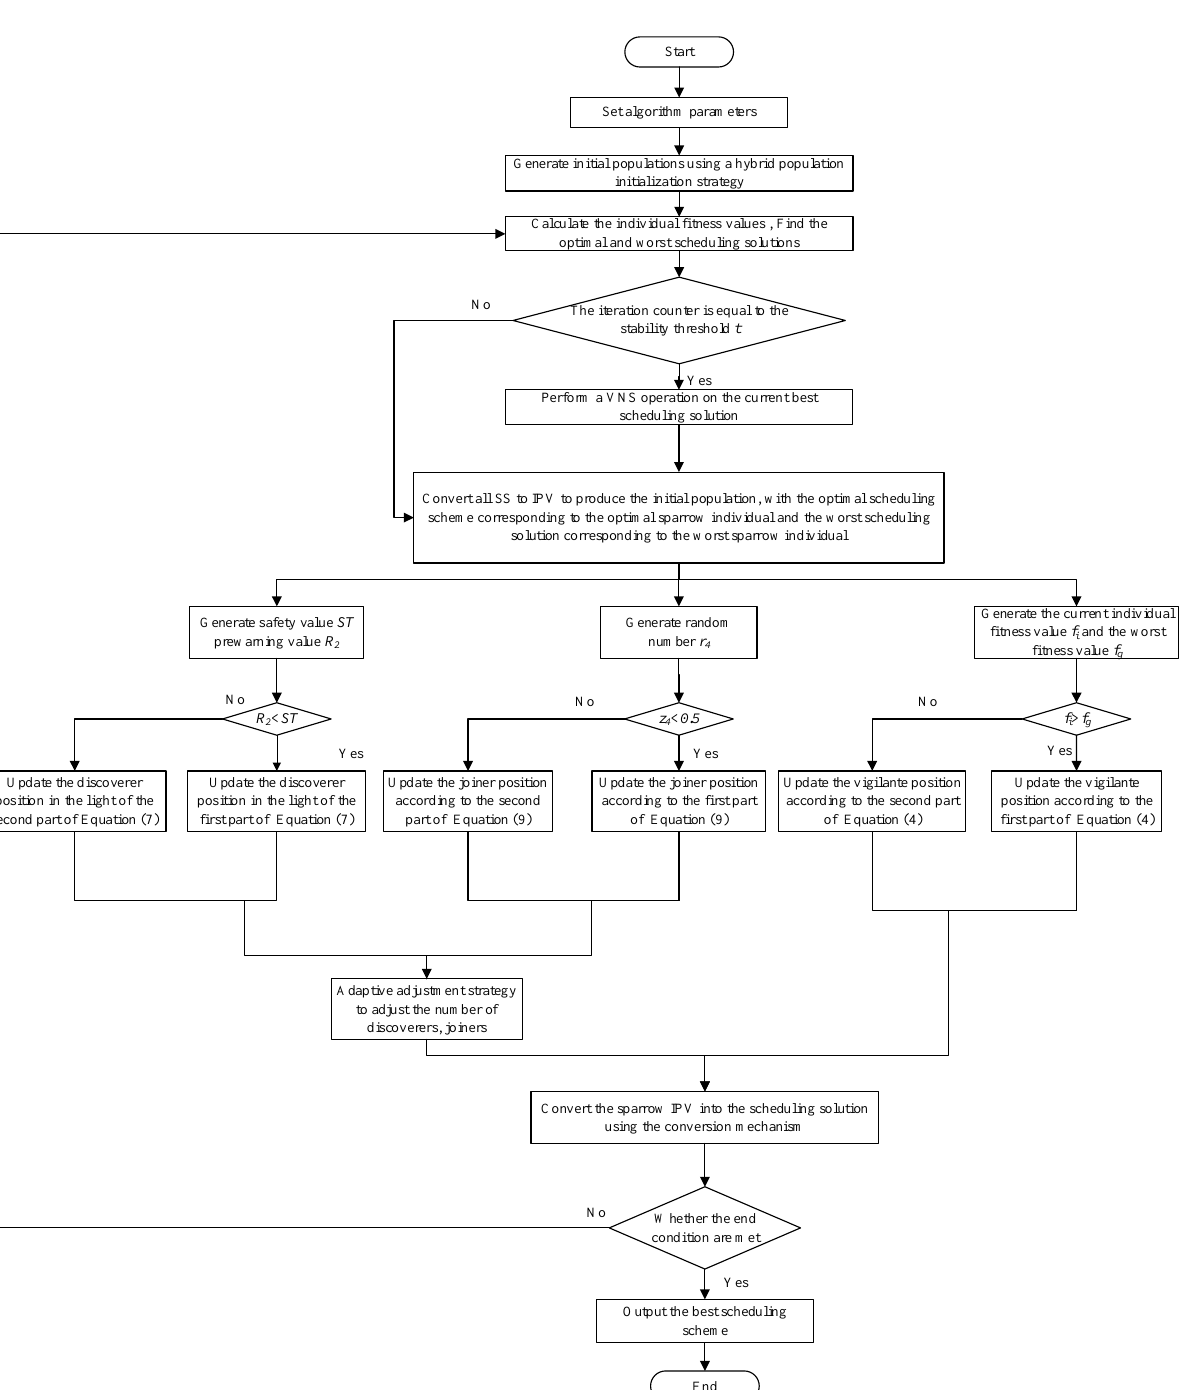
Figure 6. Flow chart of the Improved Sparrow Search Algorithm